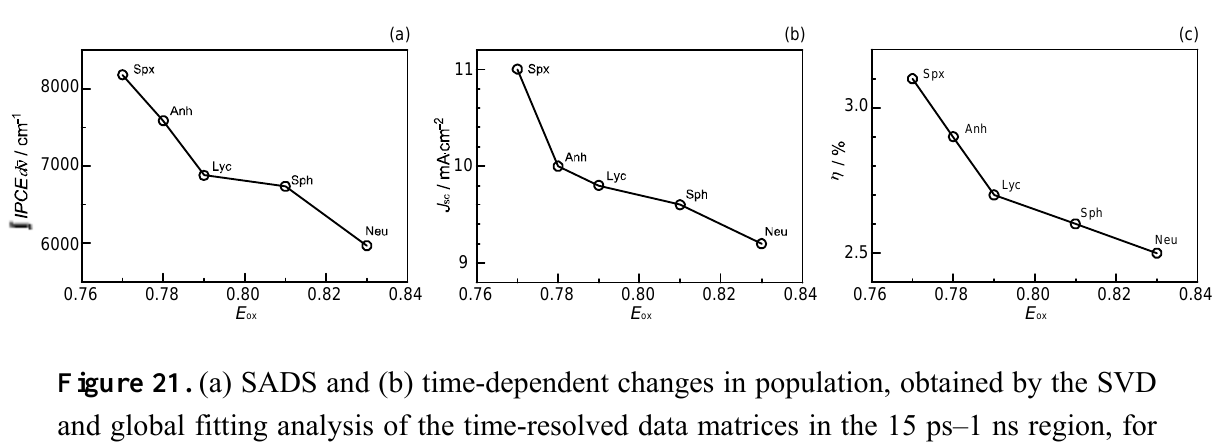
) and sc ) of the Car spacer in ox